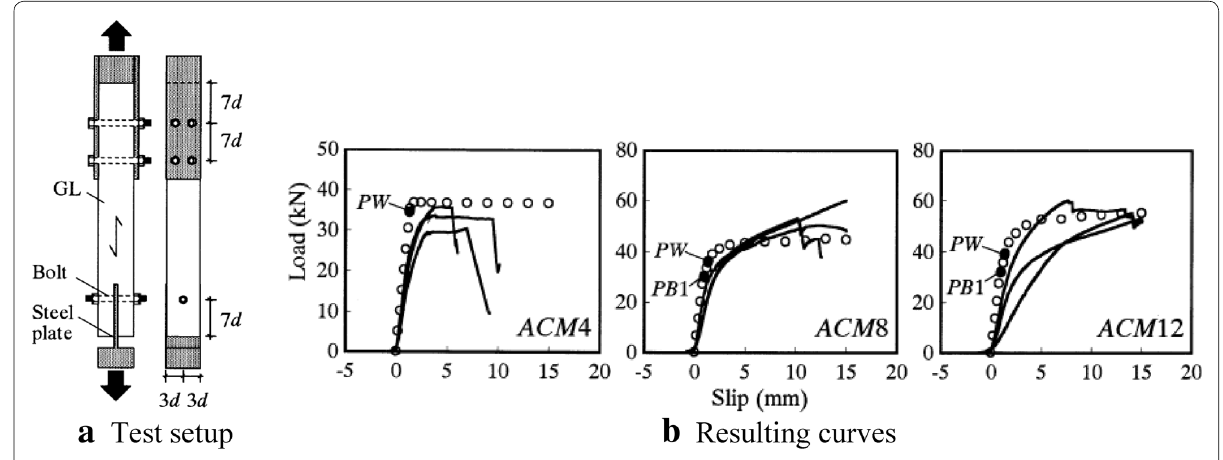
Fig. 15 Joint test information from the literature